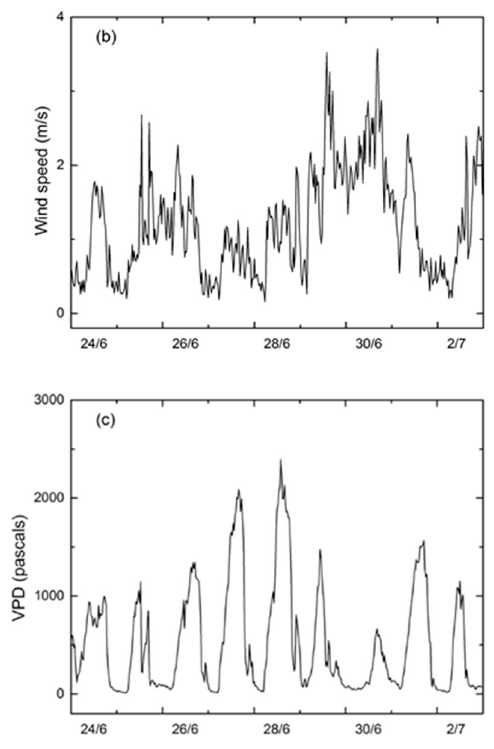
Figure 3. Half-hourly plots of ( a ) solar radiation, ( b ) wind speed, and ( c ) vapor pressure deficit (VPD) for 24 June–2 July 2014.